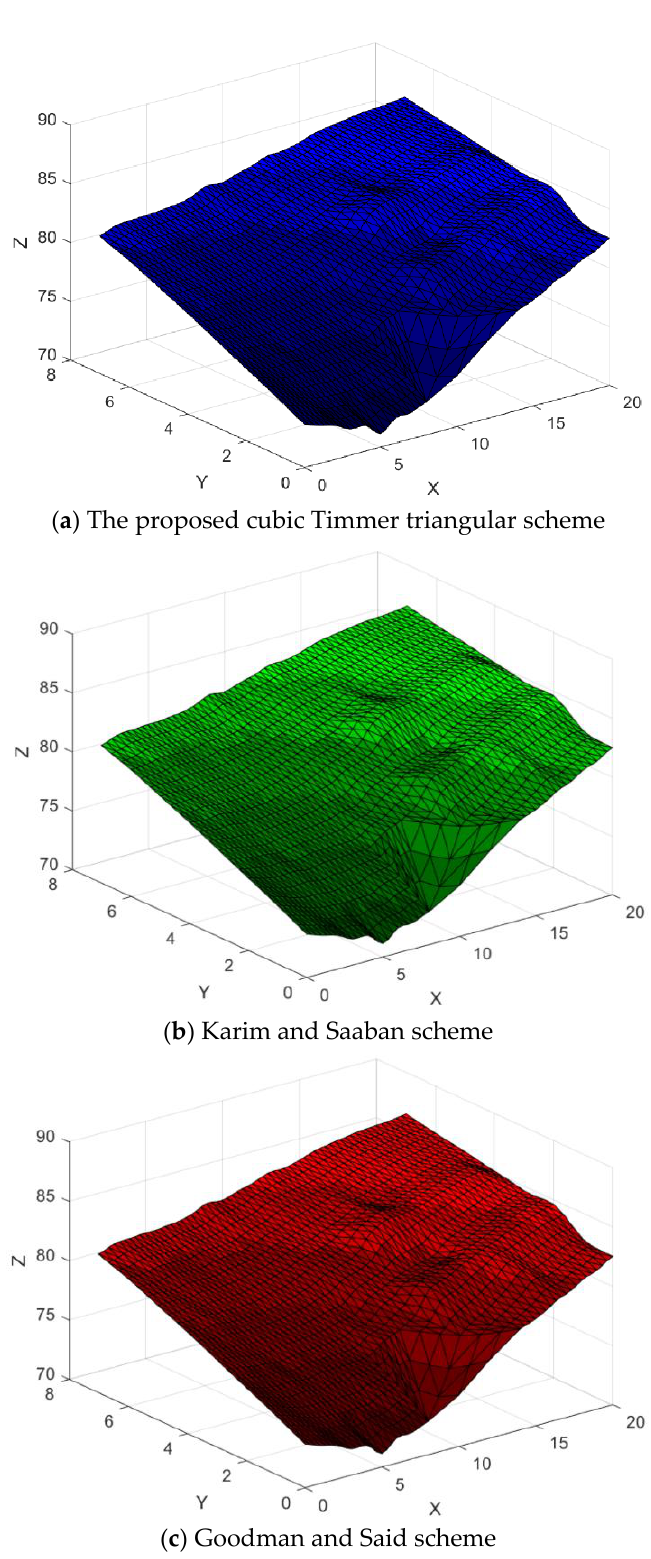
Figure 33. Surface Interpolation.